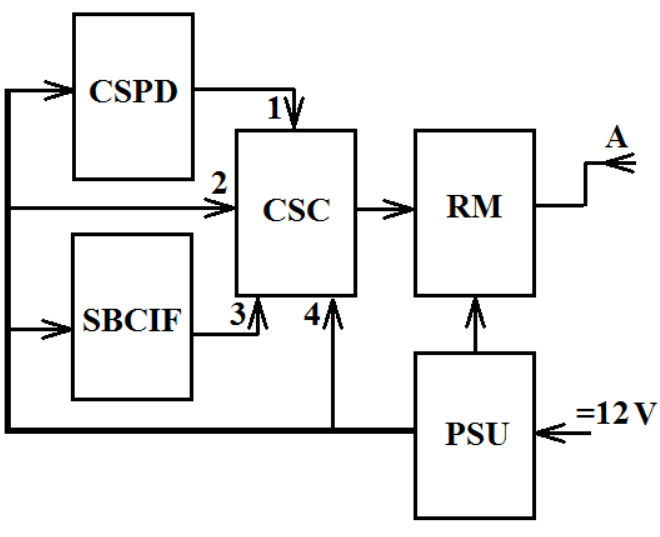
Figure 2. A structural diagram of the sensor of leakage